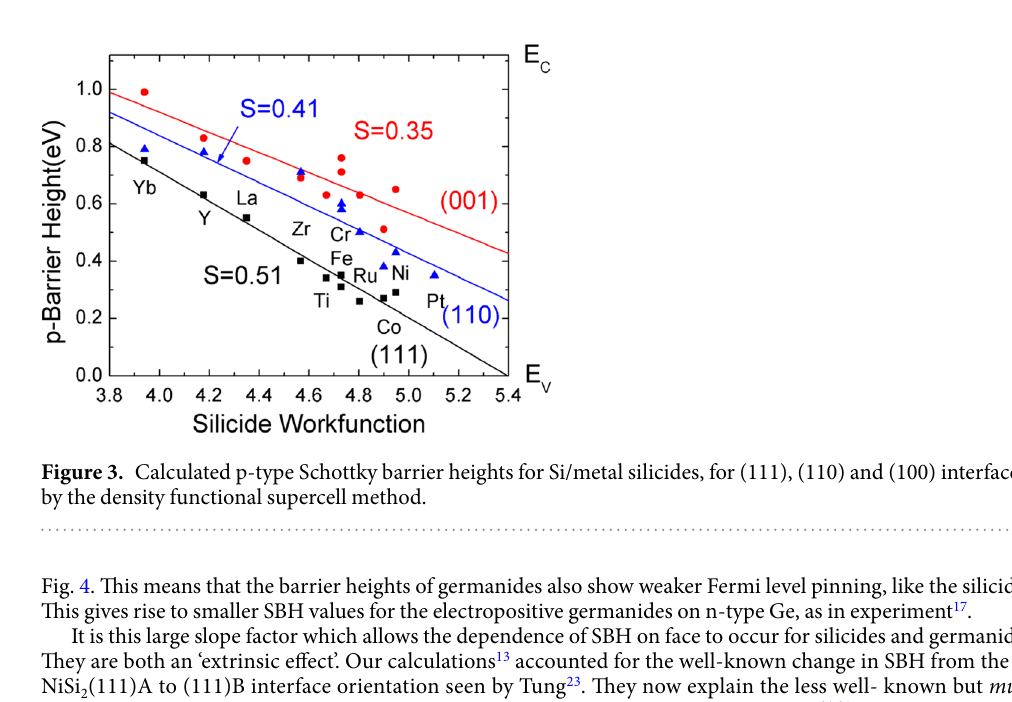
Fig. 4. This means that the barrier heights of germanides also show weaker Fermi level pinning, like the silicides. This gives rise to smaller SBH values for the electropositive germanides on n-type Ge, as in experiment 17 . It is this large slope factor which allows the dependence of SBH on face to occur for silicides and germanides. They are both an ‘extrinsic effect’. Our calculations 13 accounted for the well-known change in SBH from the Si/ NiSi 2 (111)A to (111)B interface orientation seen by Tung 23 . They now explain the less well- known but much larger (0.4 eV) reduction in n-type SBH from Si/NiSi 2 (111)A to (100) also seen by Tung 30,31 . Our calculated barrier heights for (100) facets lie above those for (111) for both Si and Ge. This is very clear if we normalise the Ge band gap and ϕ n values to those of Si, as is done in Fig. 5. Our calculated results agree with